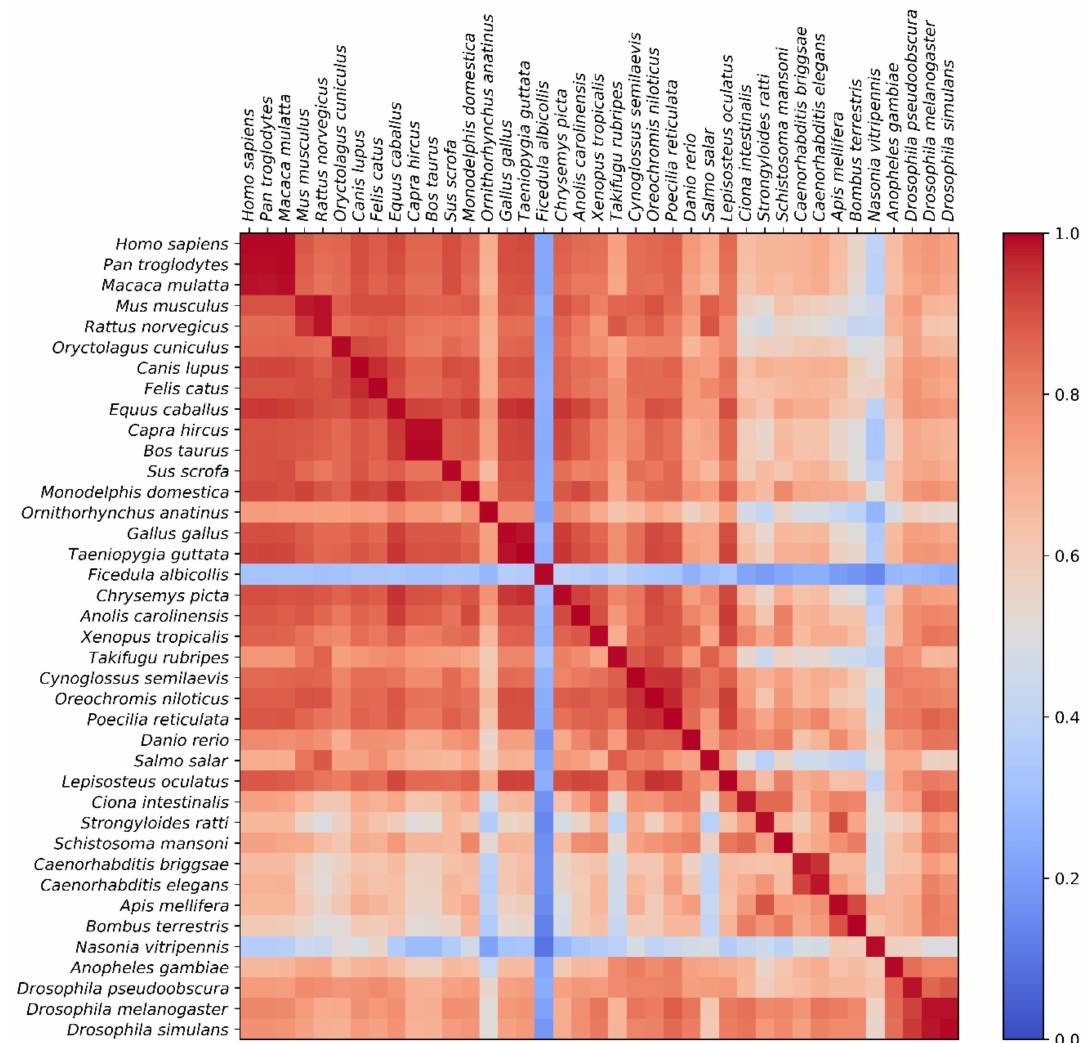
Figure 2. Heatmap of correlations between individual intron and intergenic regions ( k = 7). Each row represents the pairwise correlation values (Pearson correlation) of introns for the listed organism, while every column is associated with the intergenic region of an organism. Color scale is limited in the heatmap to values above zero for better